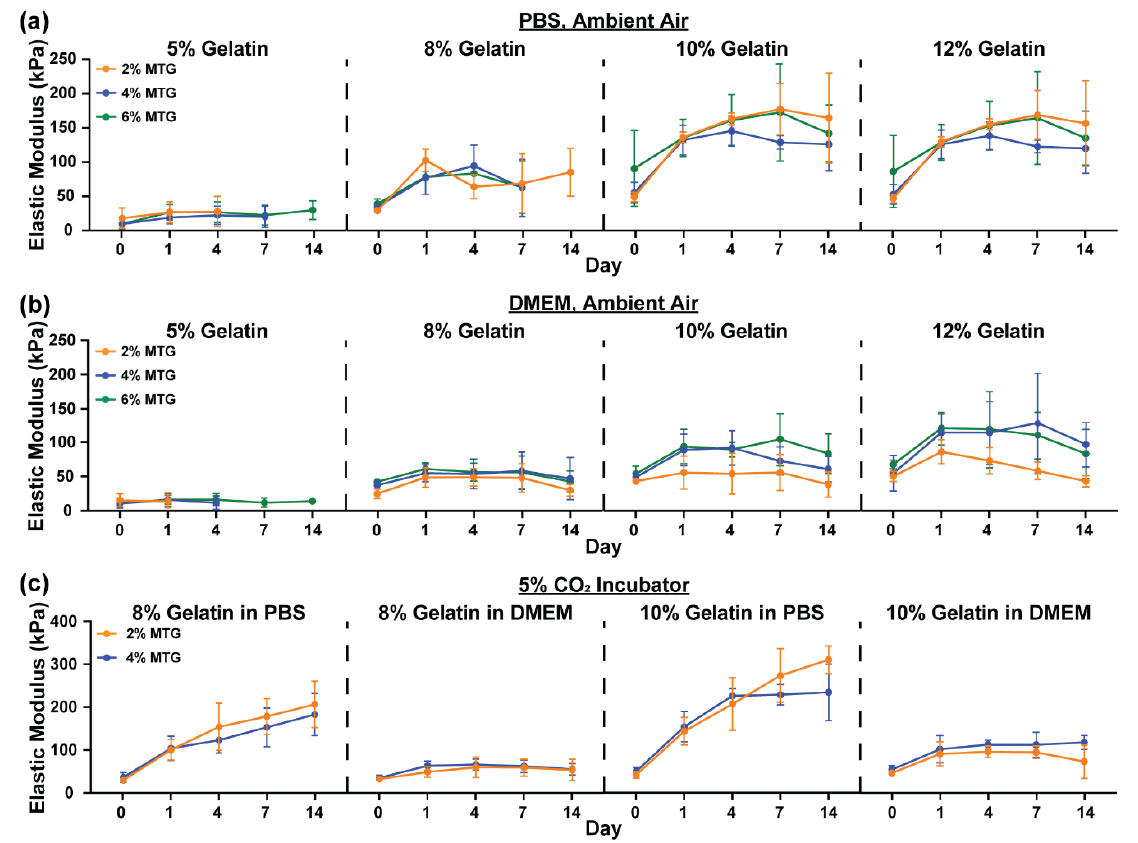
Figure 1. Elastic modulus values of gelatin-MTG hydrogels over 14 days in ( a ) PBS and ambient air, ( b ) DMEM and ambient air, and ( c ) PBS or DMEM and 5% CO 2 . Bars indicate standard deviation, n = 3–4. For some conditions, datapoints are excluded because the samples degraded prior to the measurement.